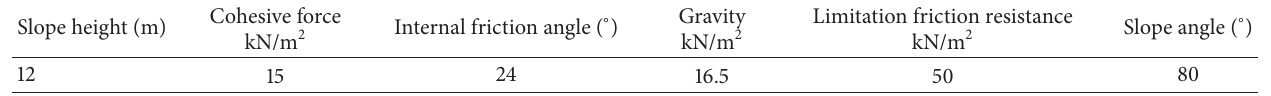
Table 1: Design parameter of slope.